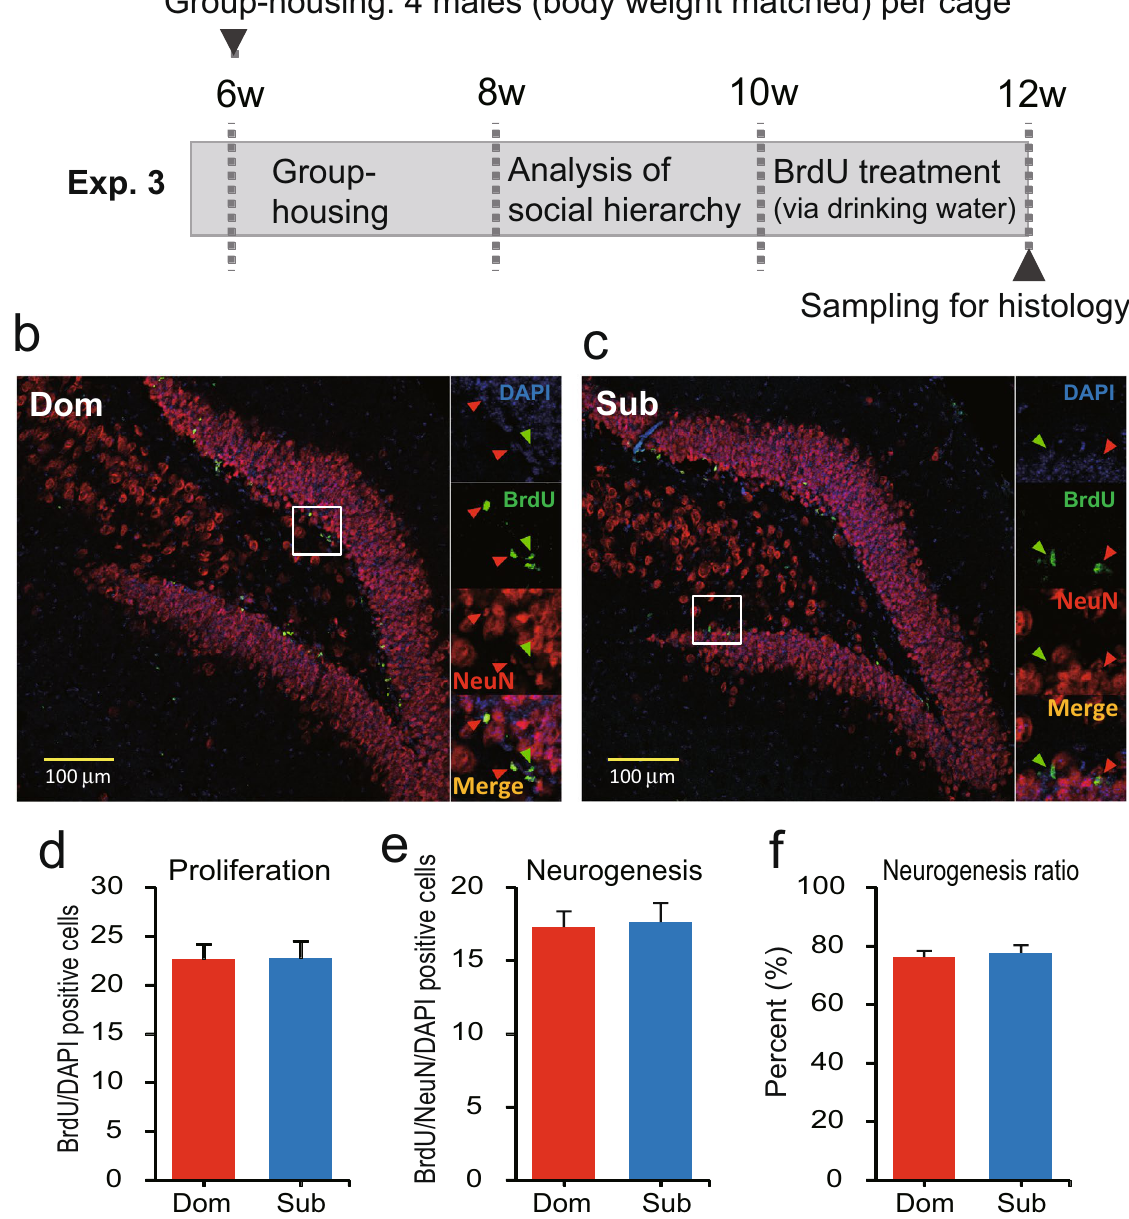
Figure 5. Comparison of adult neurogenesis between dominant and subordinate males in the hippocampus. Neurogenesis analysis was performed on dominant (Dom) and subordinate (Sub) male mice. ( a ) Experimental schedule. BrdU in drinking water (1.2 mg/mL) was supplied when the mice were aged 10–12 weeks, and the brains of the mice were collected when the mice were aged 12 weeks ( n = 8 cages) for immunohistochemical analysis. Neurogenesis analysis was performed using antibodies against BrdU, and the neural cells were labelled with NeuN antibodies. DAPI was used to detect nuclei. Examples of the immunohistochemistry of samples from a ( b ) dominant and ( c ) subordinate mouse are shown. ( d – f ) Comparisons of ( d ) cell proliferation, ( e ) neurogenesis and ( f ) percentage of neurogenesis in newly formed cells in dominant and subordinate